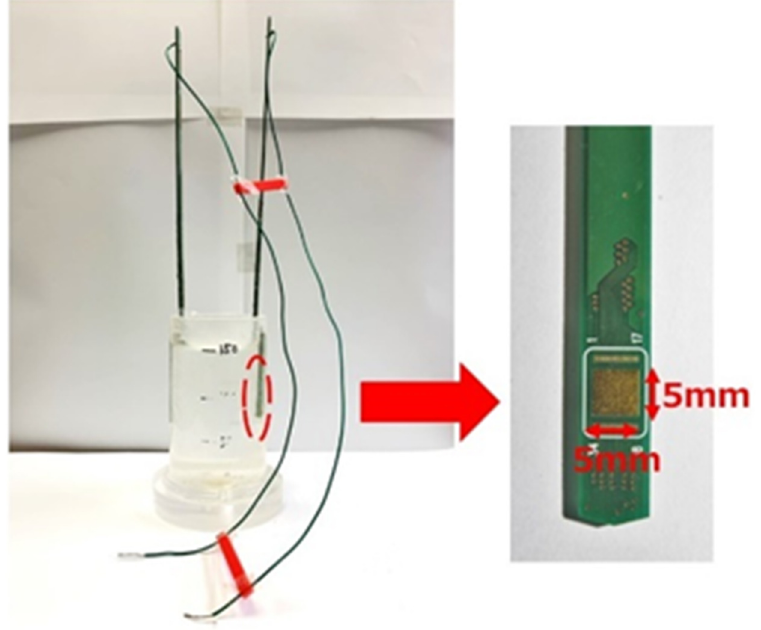
Figure 20. Measurement of the ion concentration in water using gold electrodes.